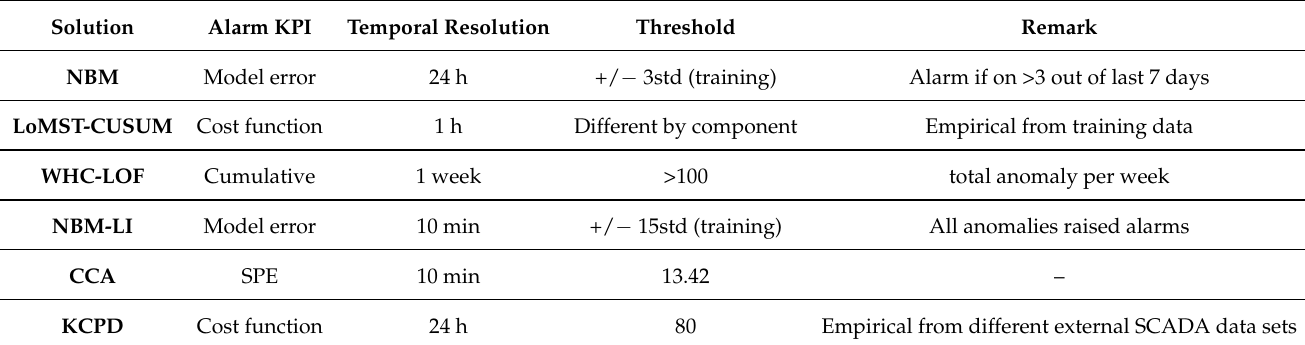
Table 8. Overview of data post-processing approaches by